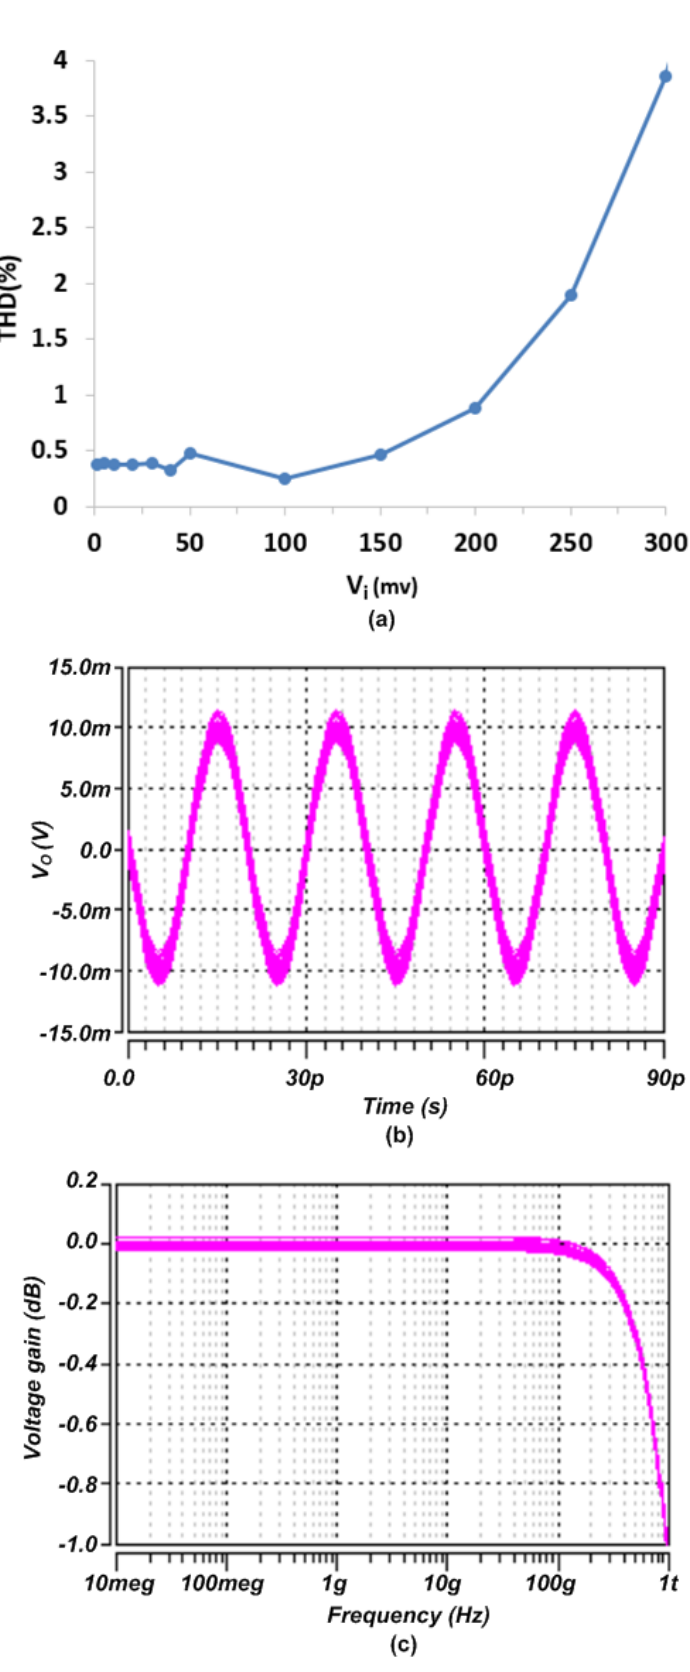
Figure 6. The UGIA: ( a ) THD Vs input voltage at 50 GHz; ( b ) Monte Carlo simulations for V o in time domain; ( c ) Monte Carlo simulations for voltage gain in frequency